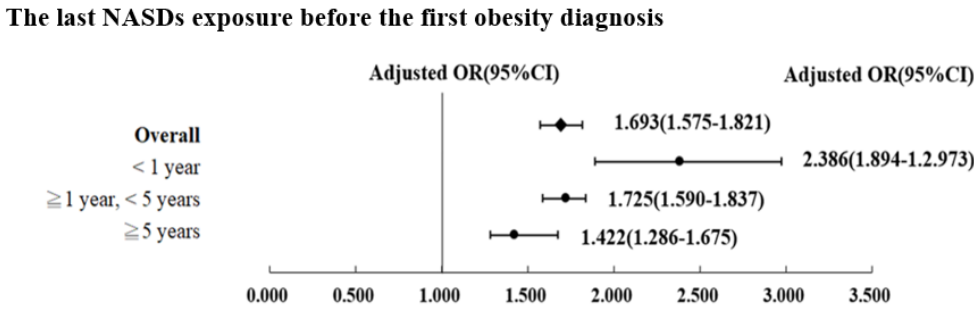
Figure 2. The last nonapnea sleep disorder exposure before the first obesity diagnosis. As shown in Figure 3, the mean exposure duration of NASDs in patients with obesity was 1.693 times that in patients without obesity (AOR, 1.693; 95% CI, 1.575–1.821). Furthermore, a longer exposure duration was associated with more severe obesity, with a dose–response effect (NASDs exposure of <1 year, AOR, 1.420; NASDs exposure of ≥ 1 to <5 years, AOR, 2.240; NASDs exposure of ≥ 5 years, AOR, 2.863).